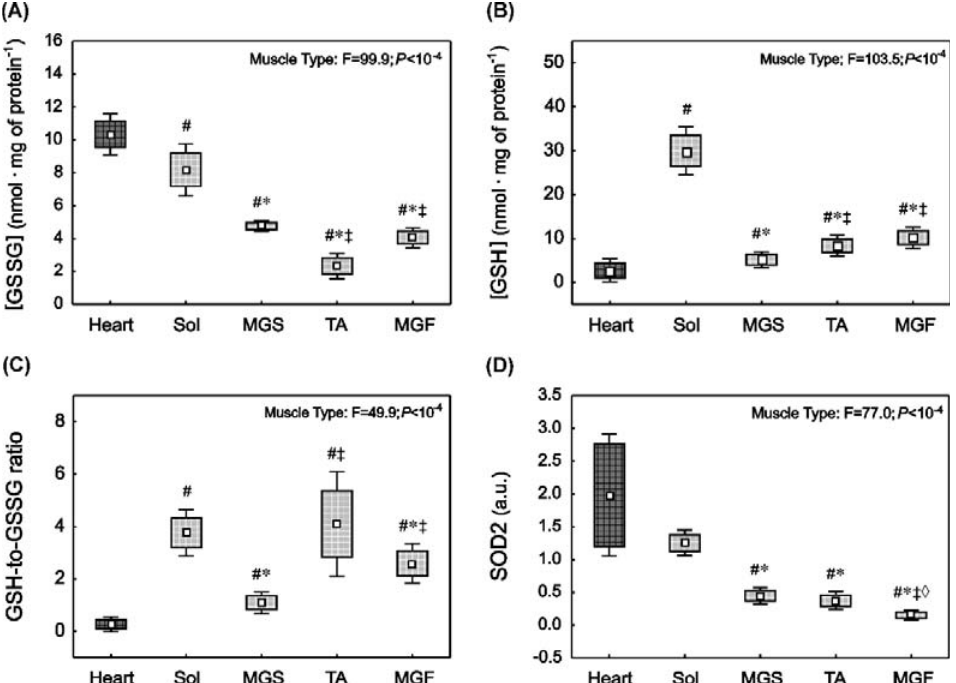
Figure 3. Oxidative stress and antioxidant capacity markers in rat striated muscles with varied muscle fibre type composition. Oxidised glutathione concentration ([GSSG], ( A )), glutathione concentration ([GSH], ( B )), total antioxidant capacity ([GSH-to-GSSG], ( C )) and superoxide dismutase type 2 content (SOD2 content ( D ) in the heart (dark square) and in the locomotory muscles (bright squares) i.e., soleus (Sol), slow part of gastrocnemius (MGS), tibialis anterior (TA) and fast part of gastrocnemius (MGF). Boxes and whiskers represent, correspondingly, the 95% confidence intervals for means and the standard deviations in samples of 12 animals for each studied muscle tissue (i.e., heart, Sol, MGS, TA and MGF). The impact of muscle type on the analysed variables is presented. Results of one ‐ way ANOVA and Tukey post ‐ hoc are shown in ( D ), whereas Welch ANOVA and post ‐ hoc Games–Howell results are presented in ( A – C ). # denotes significant difference to the heart; * denotes signi fi cant di ff erence to the Sol; ‡ denotes signi fi cant difference to MGS; ◊ denotes significant difference to TA.